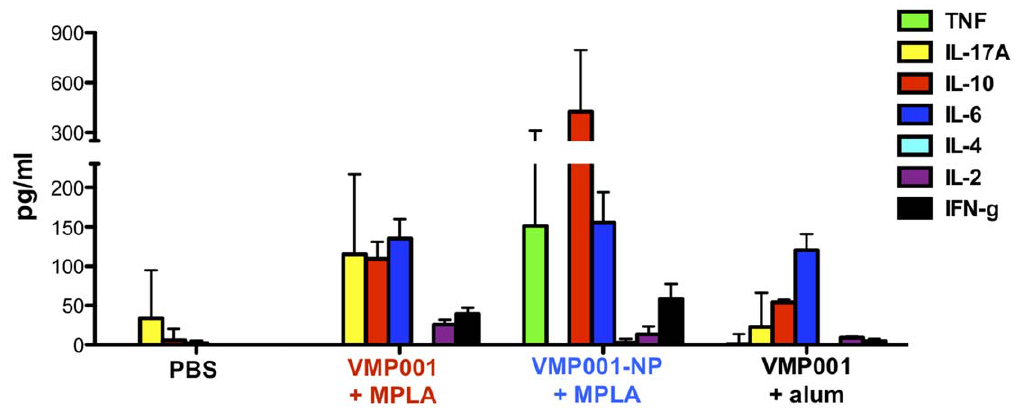
Figure 4. Vaccination with VMP001-NPs enhances cellular immune responses. C57Bl/6 mice were vaccinated on days 0 and 21 with 1 m g VMP001 and alum or with 5 m g MPLA in either soluble or VMP001-NP formulations, and splenocytes isolated on day 28 were stimulated with 25 m g/ ml VMP001 ex vivo . After 2 days, the supernatants were assayed for the presence of cytokines by ELISA.